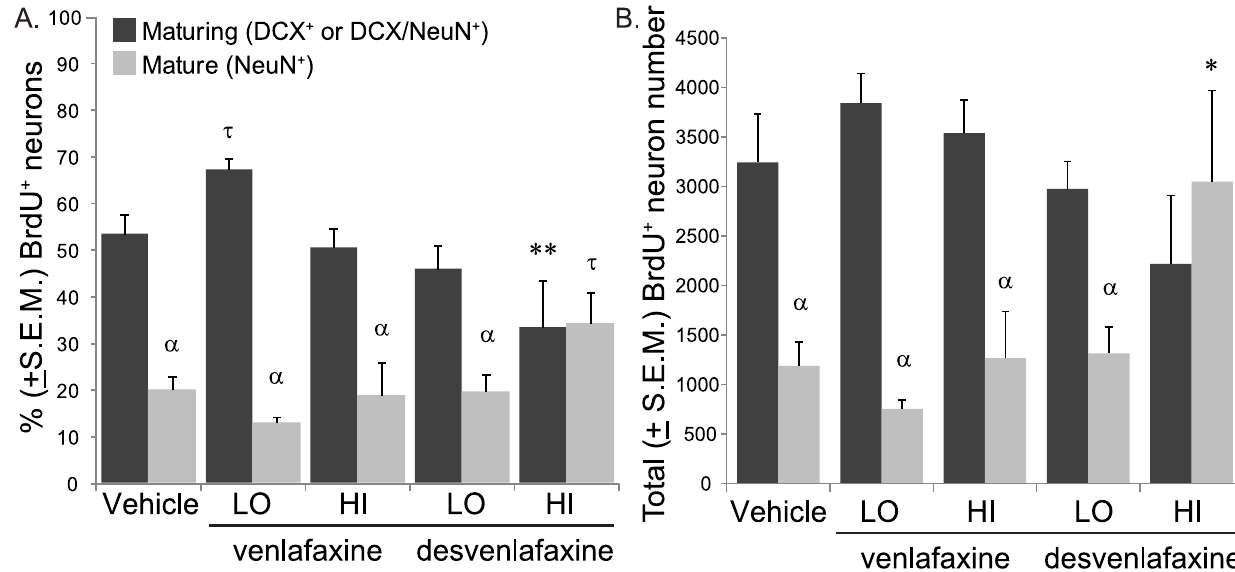
Figure 4. High-dose desvenlafaxine may accelerateneuronal maturation neurons in the denate gyri of adult male rats. A) Quantification of maturing (DCX + and DCX + NeuN + )and mature (NeuN + alone) neuronal phenotypesshowed that a significantly higher percentage of BrdU + cells expressed maturing versus mature phenotypes in the dentate gyri of vehicle- (p=0.005), VEN-LO- (p=0.00008), VEN-HI- (p=0.009), DES- LO- (p=0.03) treated rats but similar proportionsexpressed maturing and mature phenotypes in the dentate gyri of DES-HI-treatedrats ( p =0.56). Relativeto BrdU + cells in vehicle-treated rats,a significantly lower proportion expressed a maturing neuronal phenotype (**p=0.005)and more tended to express a mature neuronal phenotype ( t p=0.08). B) Quantification of number of new maturing and matureneurons showed that more new maturing versus new mature neurons were foundin the dentate gyri of vehicle- ( p =0.03),VEN-LO- ( p =0.002),VEN-HI- ( p =0.02),DES-LO- ( p =0.05)treated rats but similar numbers of maturing and mature new neurons were foundin the dentate gyri of DES-HI-treated rats ( p =0.32)and significantly more BrdU + mature neurons werefound in the dentate gyri of DES-HI versus control rats (*p=0.02).